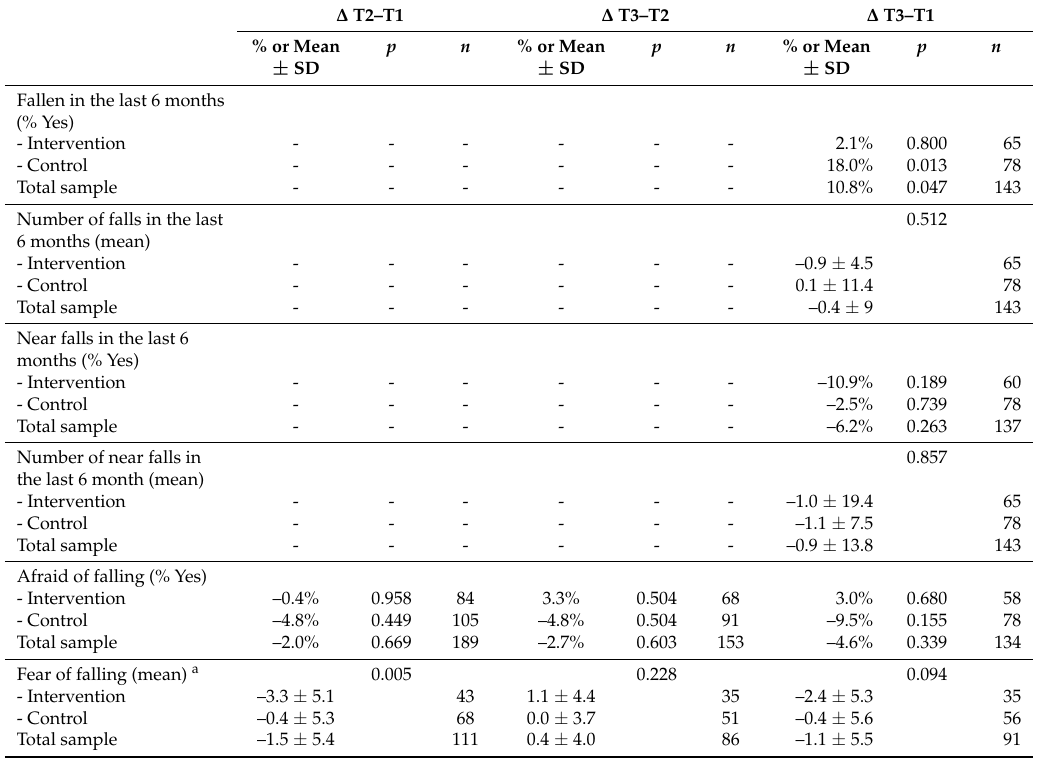
Table 3. Changes in fall-related outcomes between baseline and follow-up at 3 and 6 months.